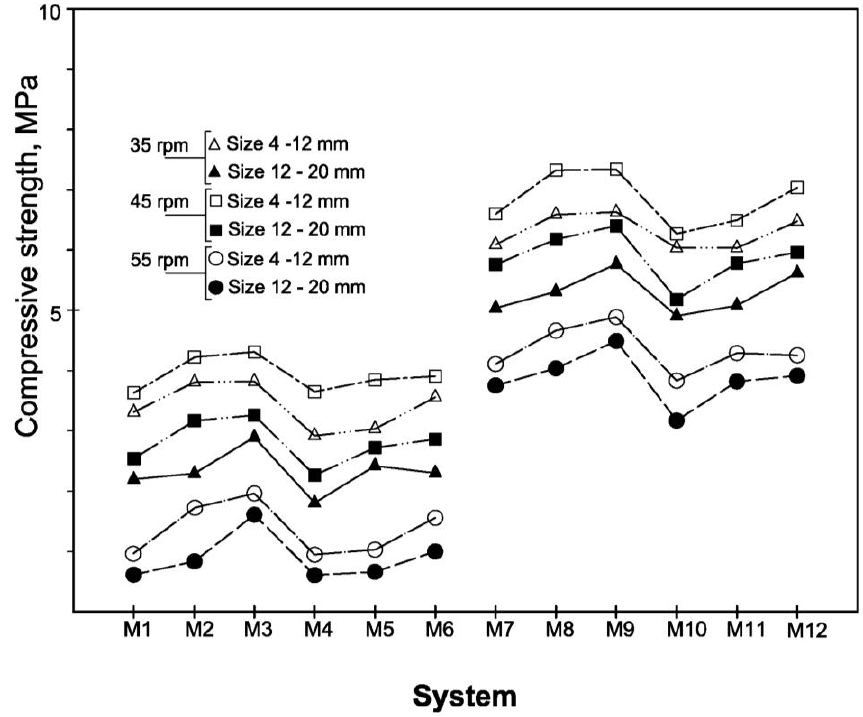
Figure 5. Compressive strength of the artificial aggregates after 56 days curing.